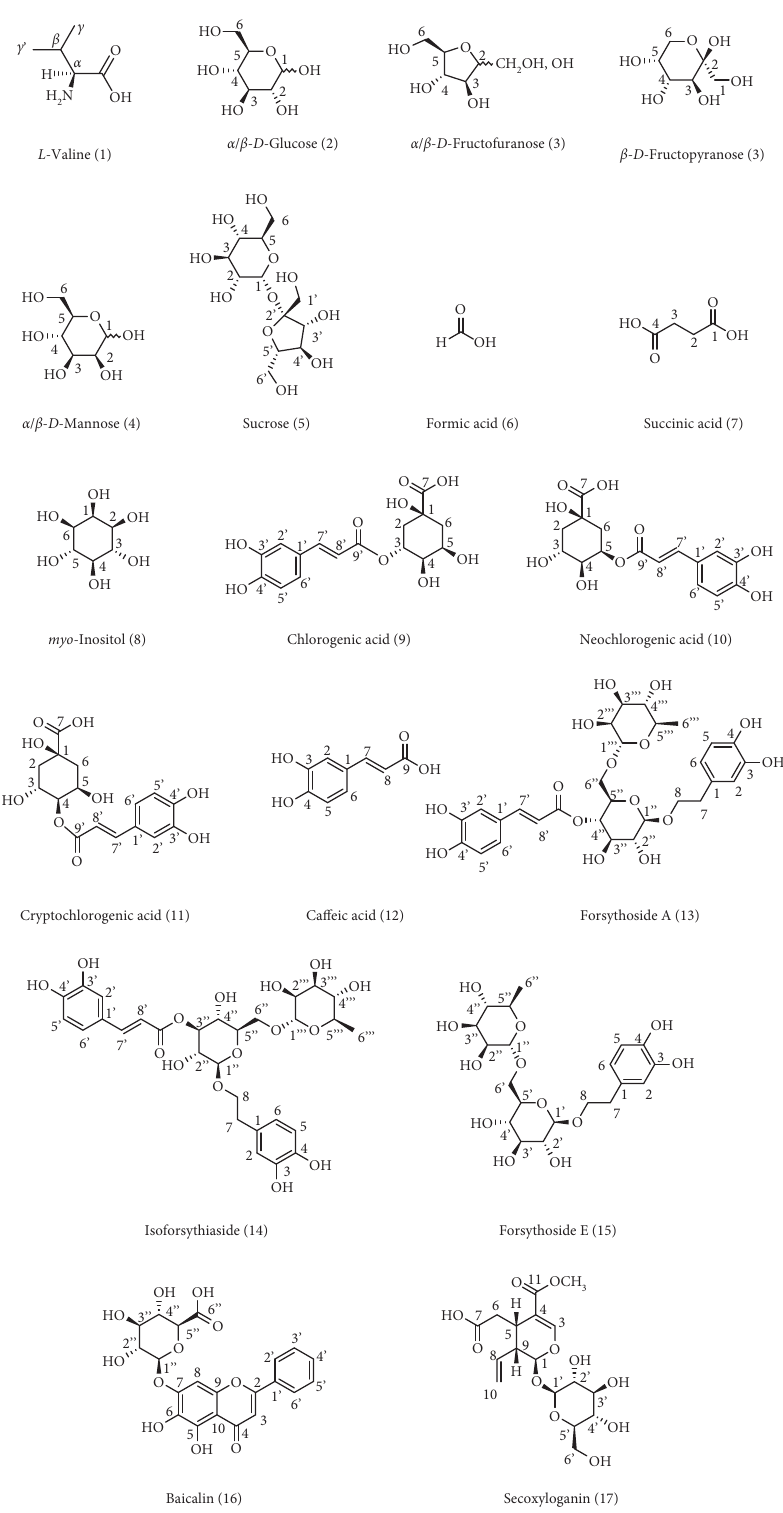
Figure 2: Chemical structures of 17 components in